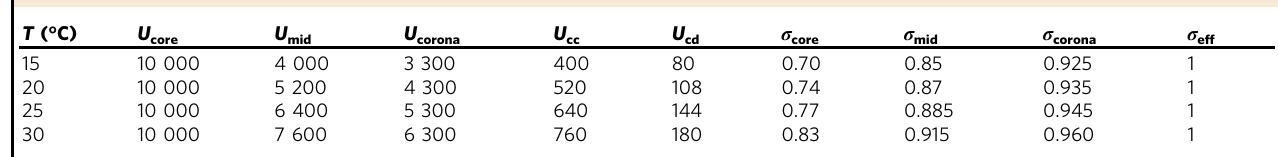
Hertzian strengths U core , U mid , U corona and U cc in k B T and lengths σ core , σ mid , σ corona and σ eff (in units of σ eff ) as used for colloid-colloid interactions. Hertzian strength U cd in k B T used to describe the colloid-depletant (non-additive) interaction in binary